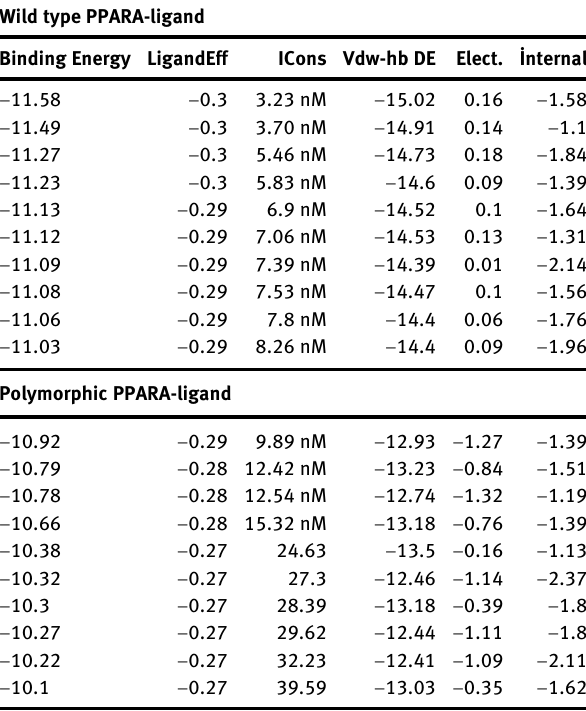
Table  : PPARA docking